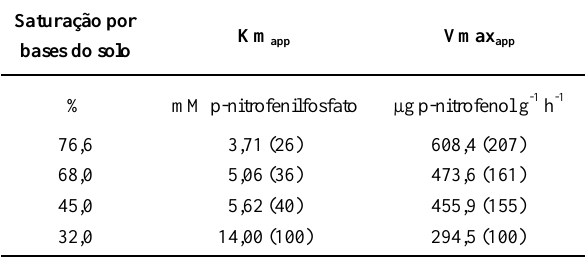
Quadro 3. Valores de Km e Vmax das fosfatases, app app determinadas em tampão universal modifica- do, ajustados para valores de pH corresponden- tes aos obtidos no solo submetido aos diferen- tes valores de saturação por bases (números entre parênteses correspondem a valores